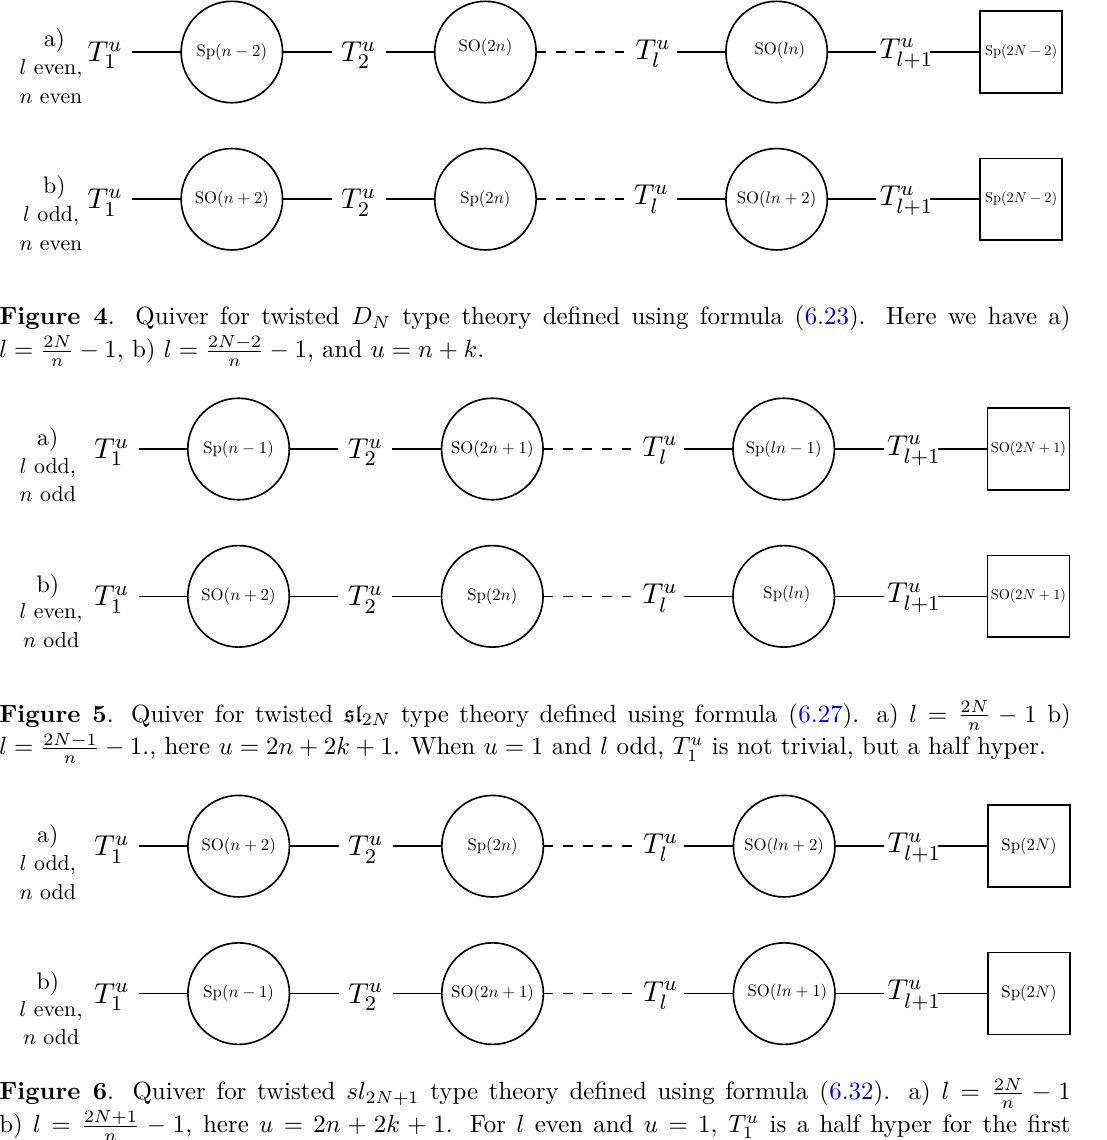
Figure 6 . Quiver for twisted sl 2 N +1 type theory defined using formula (6.32). a) l = 2 N b) l = 2 N +1